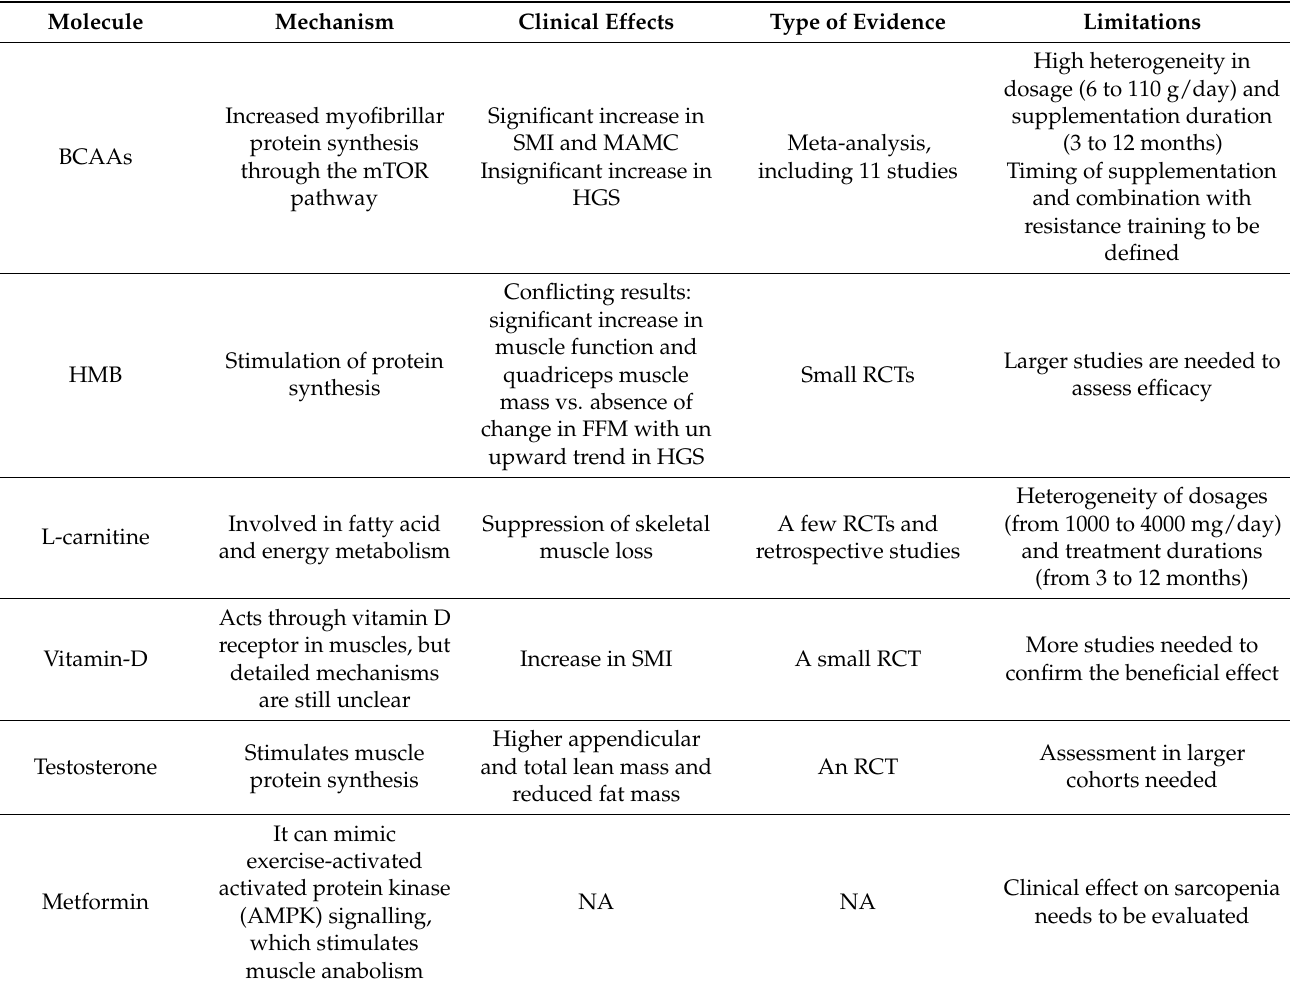
Table 2. Supplementations and drugs for prevention and treatment of sarcopenia in LC